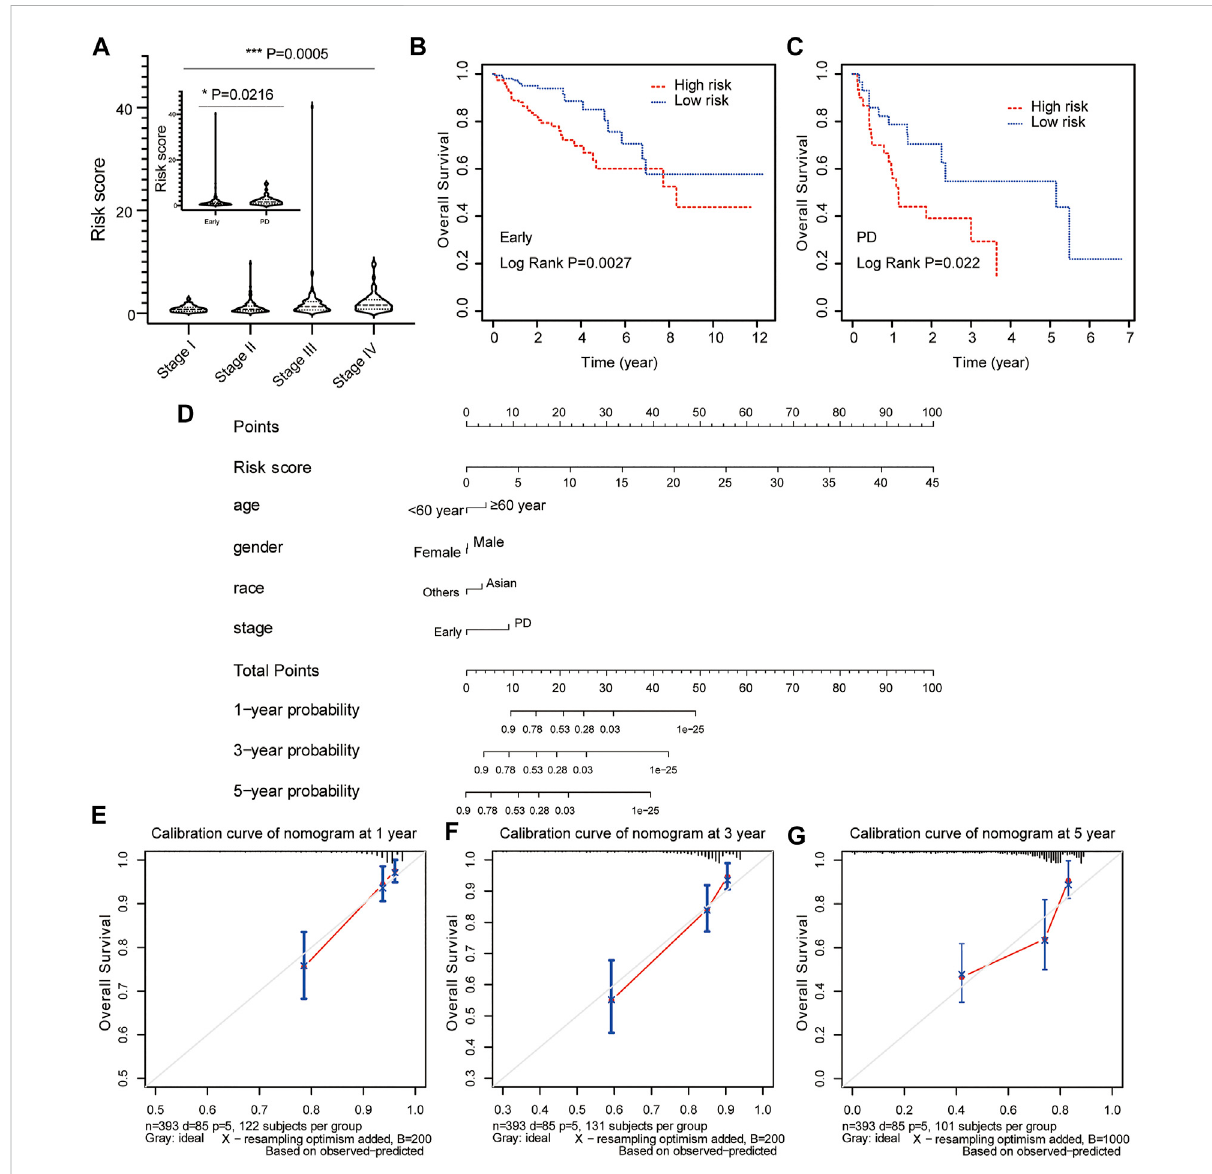
FIGURE 6 Construction and calibration of nomogram for prognostic prediction in CRC patients. (A) The association betweenrisk score and clinical stage. The prognostic value of the risk signature in patients with early/locally advanced CRC (stage I – III) (B) and advanced CRC (stage IV) (C) . (D) The predictive nomogram based on risk score and clinical parameters for overall survival prediction at 1, 3, and 5 years. Calibration curve of the nomogram at 1 year (E) , 3 years (F) , and 5 years (G)